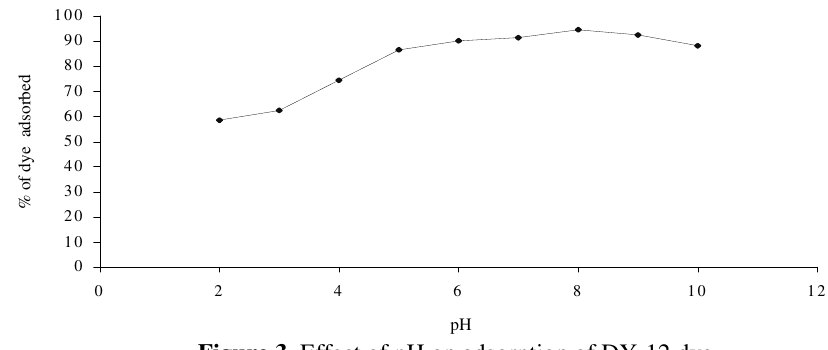
Figure 3. Effect of pH on adsorption of DY-12 dye